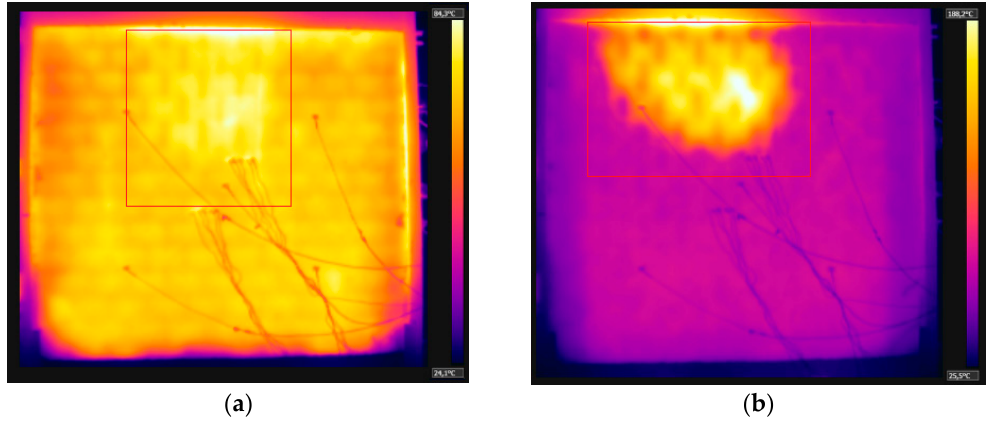
Figure 18. ( a ) Spalling begins—80 min, and ( b ) spalling ends—240 min.